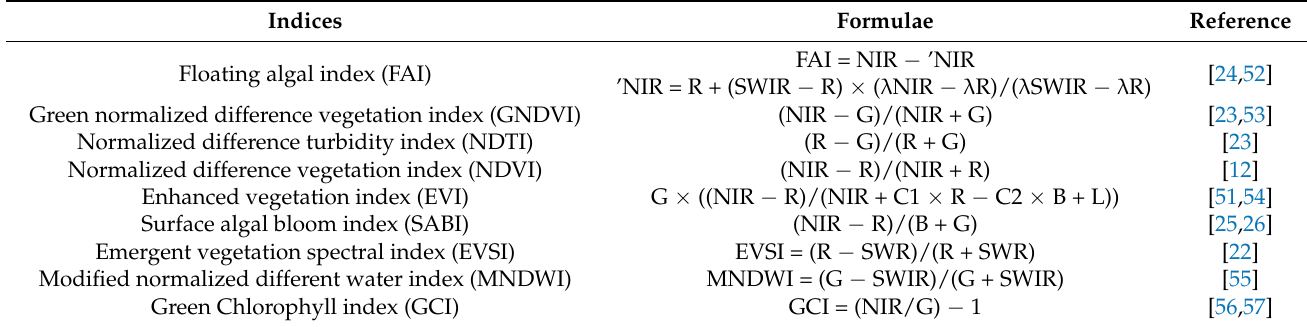
Table 3. The list of indices compared in this